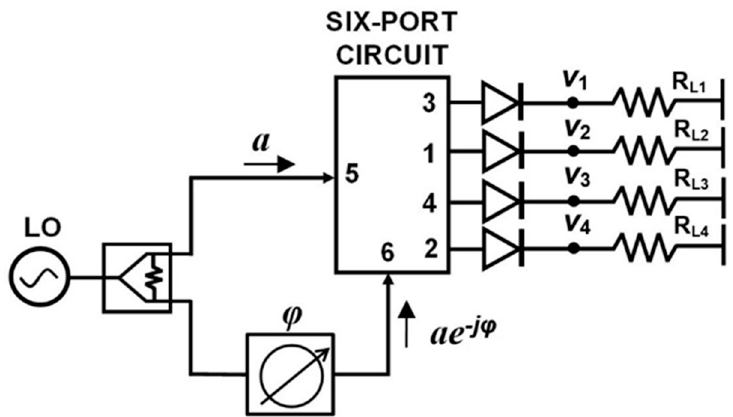
Figure 34. Harmonic balance simulation simplified block diagram.